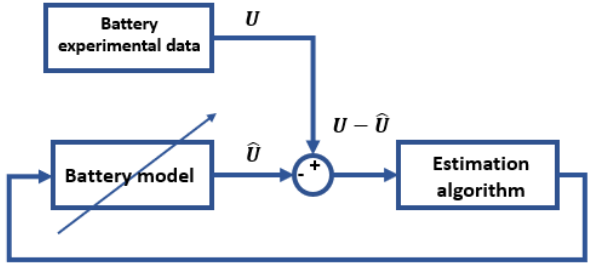
Figure 8. Iterative approach to battery model parameter estimation.